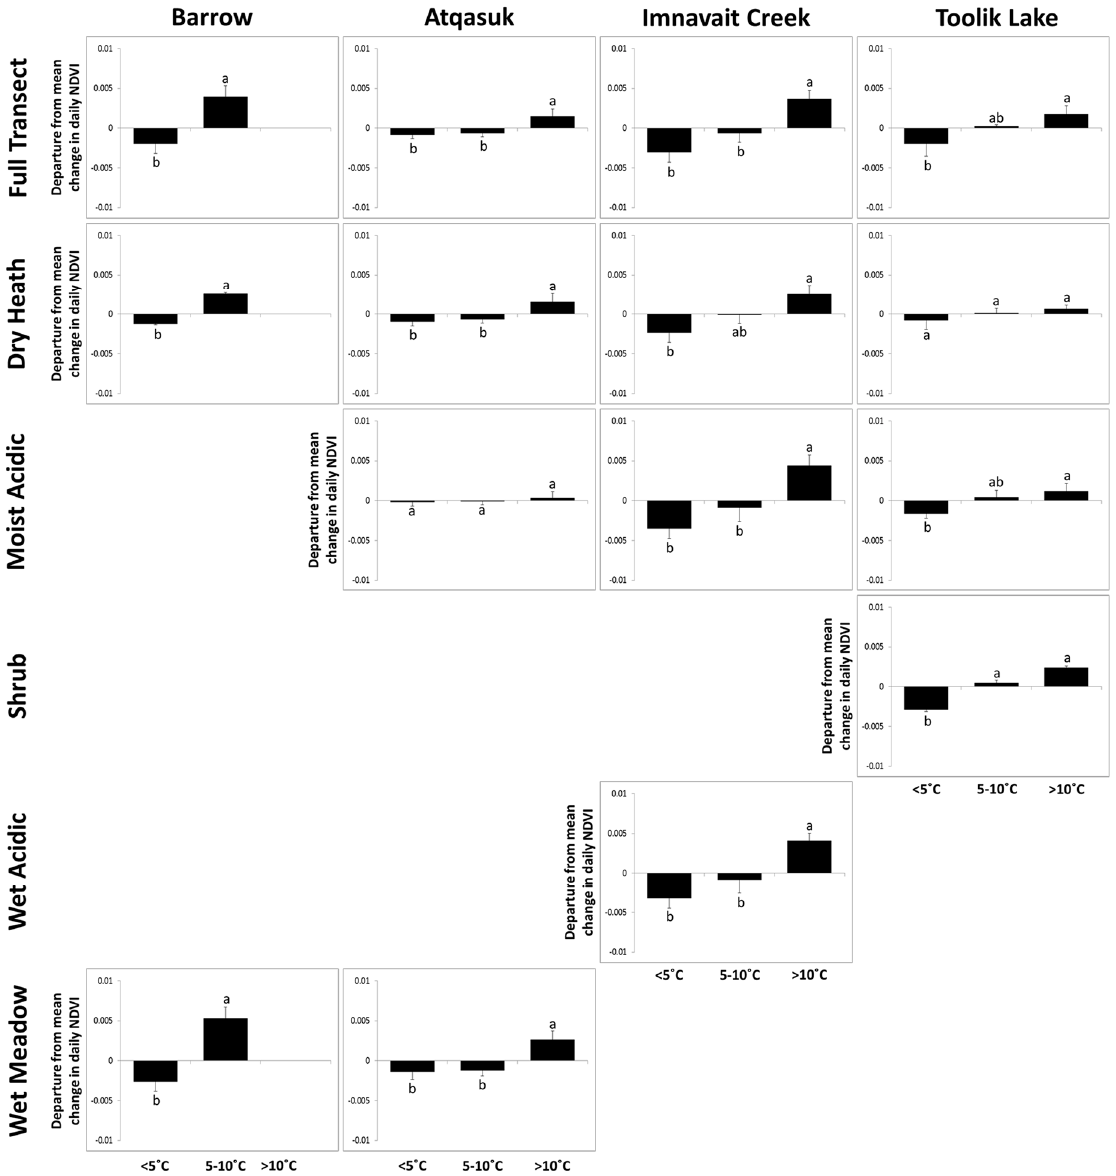
Figure 6. Increases in NDVI, shown as departure from the average, over three days following days of temperatures <5 °C, 5–10 °C, and >10 °C for the four MISP transects and component plant habitats as June averages. Positive values indicate an increase in the rate of NDVI increase (greening) compared with the average rate, and negative values a decrease in the rate of NDVI increase. The letters denote statistical differences as determined with repeated measures analysis of variance with Tukey’s post hoc analysis.